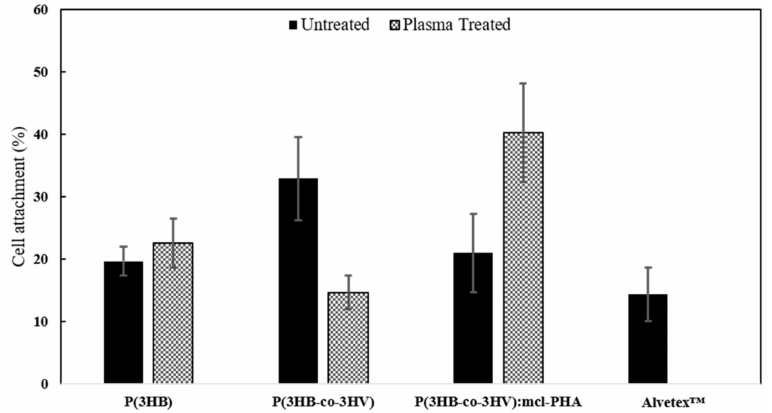
Figure 8. Comparison of the HDFns adhesion on different types of PHA based scaffolds with and without oxygen plasma treatment, measured by MTT assay. A commercial 3D mesh, Alvetex™, has been used as reference. The cell attachment values are the ratio between the absorbance of each sample and the attachment attained in polystyrene